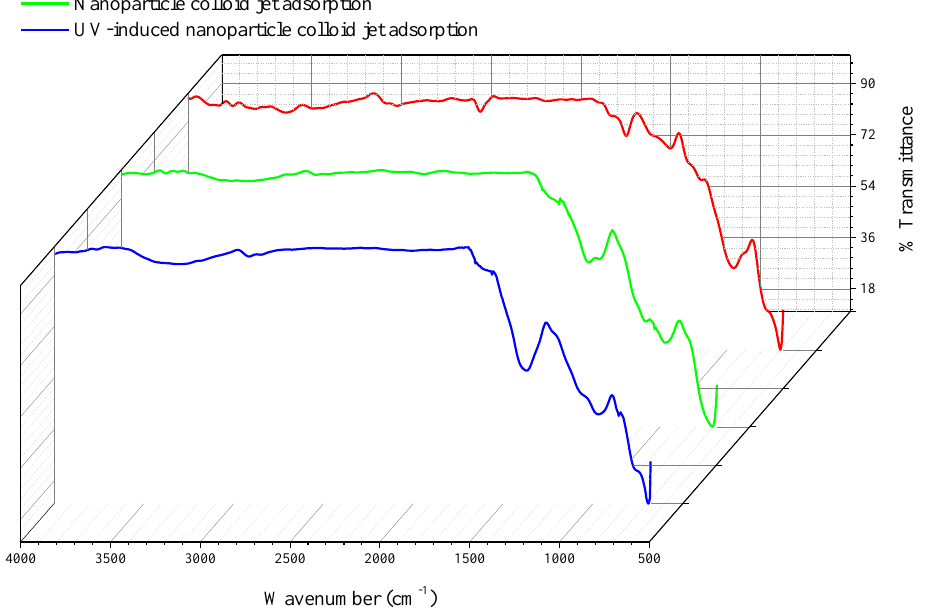
Figure 8. FT-IR of the Si workpiece samples before and after adsorbing on the TiO 2 nanoparticles.